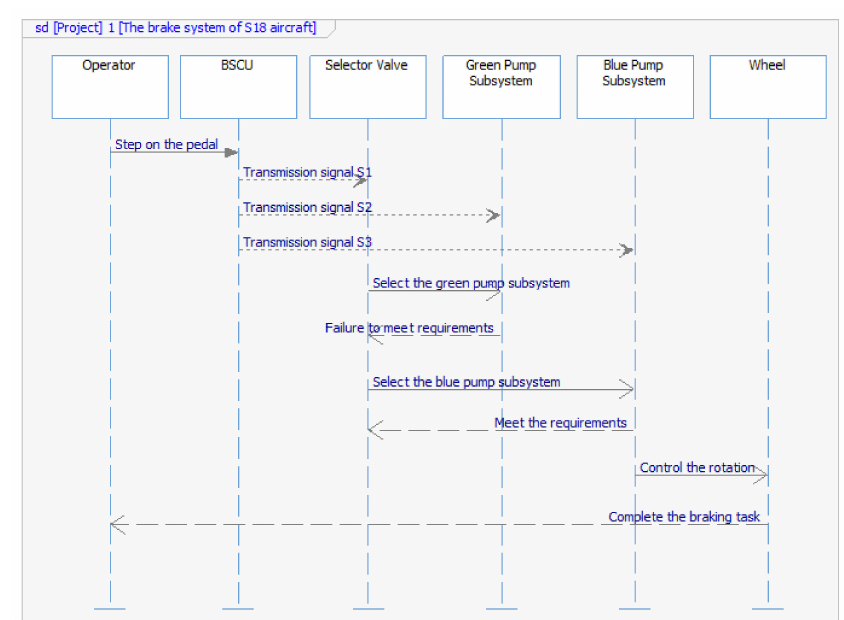
Figure 6. Sequence diagram of brake